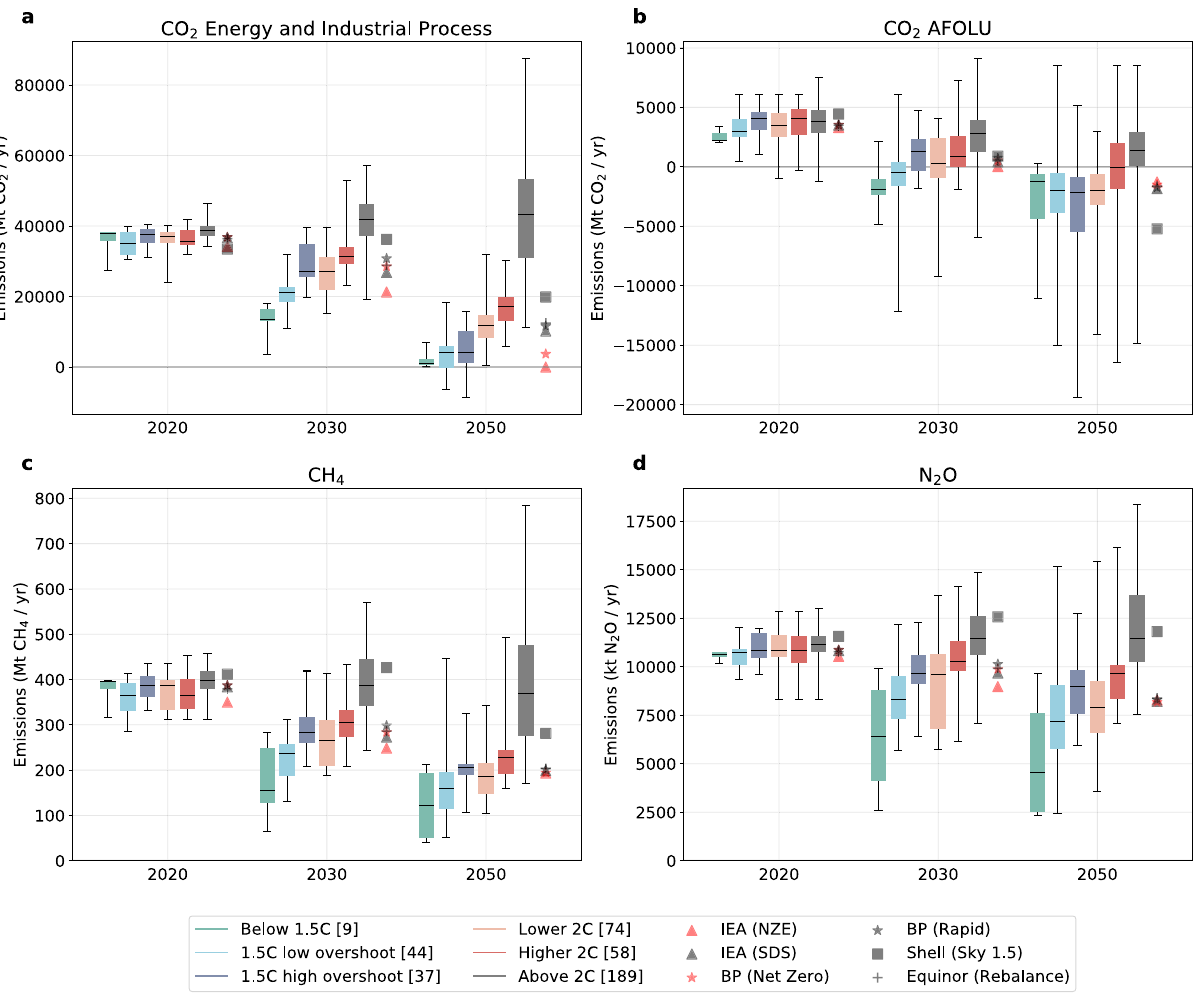
Fig. 2 Comparison of emission characteristics between the SR1.5 pathways and the institutional scenarios assessed in this study. a CO 2 emissions from energy and industrial processes, ( b ) CO 2 emissions from Agriculture, Forestry, and Land Use (AFOLU), ( c ) CH 4 emissions, ( d ) N2O emissions. The box represents the interquartile range with the median represented by the solid horizontal line. The whiskers represent the full range across the corresponding pathway class. All emissions (apart from panel a) are in fi lled using the Quantile Rolling Windows (QRW) method, except for Shell Sky 1.5 which reports these